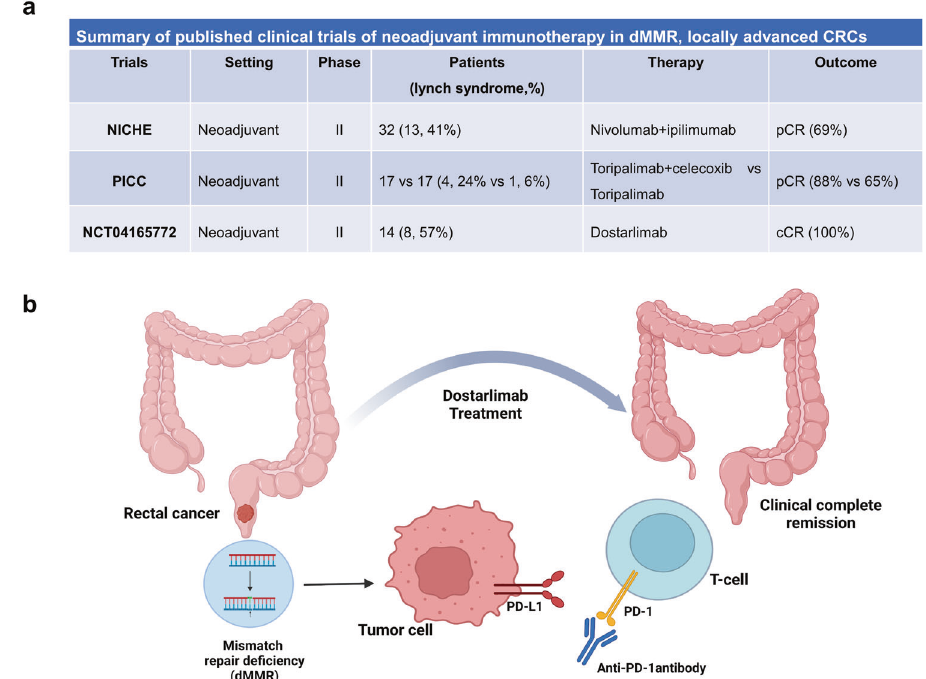
Fig. 1 PD-1 blockade as neoadjuvant therapy in DNA dismatch repair – de fi cient colorectal cancers. a Summary of published clinical trials of neoadjuvant immunotherapy in dMMR, locally advanced CRCs. b The administration of anti-PD-1 antibody dostarlimab achieved clinical complete remission in the patients with dMMR, locally advanced rectal cancer. dMMR mismatch repair-de fi ciency, CRC colorectal cancer, pCR pathological complete response, cCR clinical complete response, PD-1 programmed death protein 1, PD-L1 programmed death ligand-1. Panel b was generated on